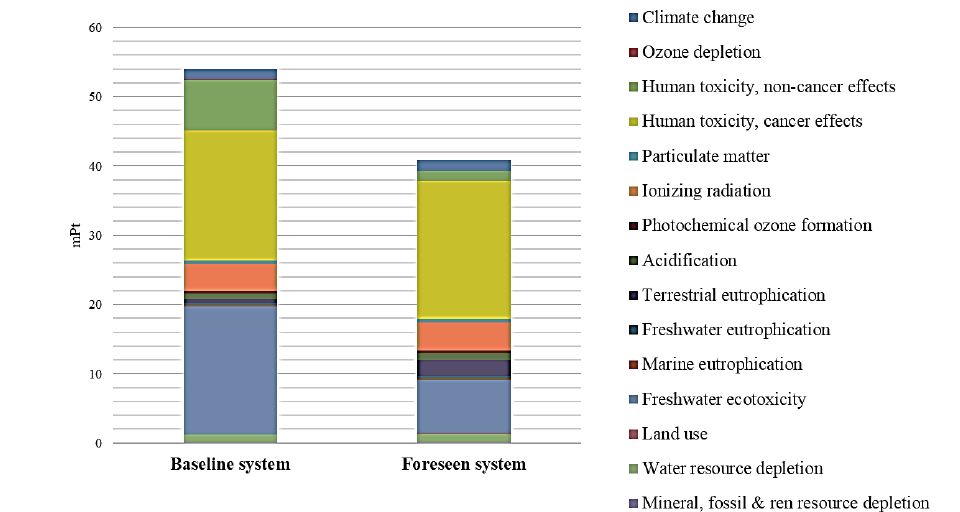
Fig. 3. Comparison between the impacts deriving from the baseline and the foreseen